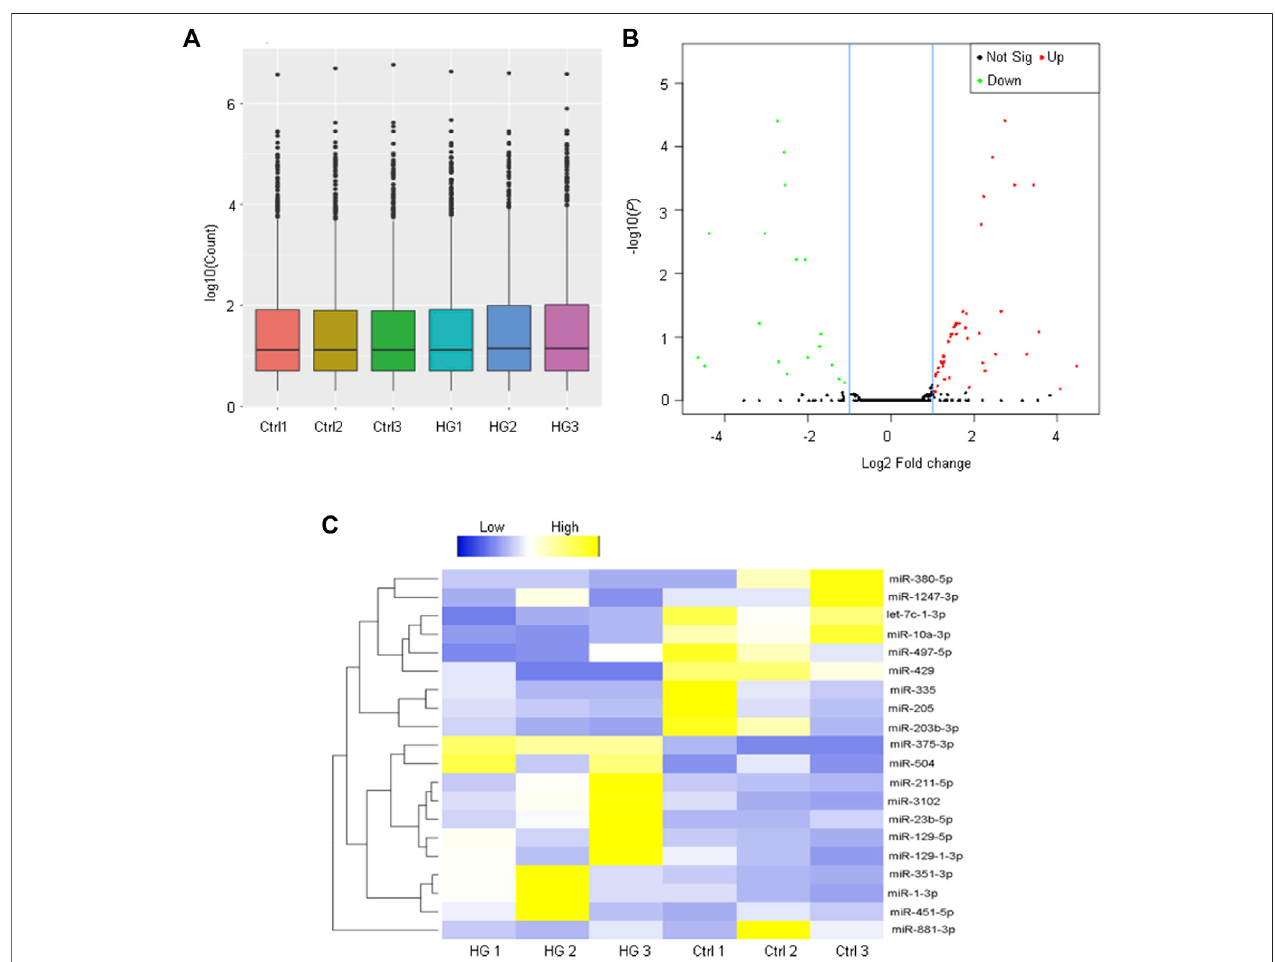
FIGURE 2 | Analysis of miRNA pro fi ling of EPCs derived from the bone marrow. (A) The box plot is depicted to show the distribution of miRNA expression pattern acrossdifferentsamples.Theboxeswithacentrallineandtwotailsrepresentthemedianofthedataandtheupperandlowerquartiles,respectively. (B) Thevolcanoplot shows the differentially expressed miRNAs between EPCs derived from the bone marrow with or without high-glucose treatment. (C) Heatmaps generated from hierarchical cluster analysis display 20 differentially expressed miRNAs between EPCs derived from the bone marrow with or without high-glucose treatment. Yellow color and blue color indicate the up-regulated and down-regulated miRNAs,